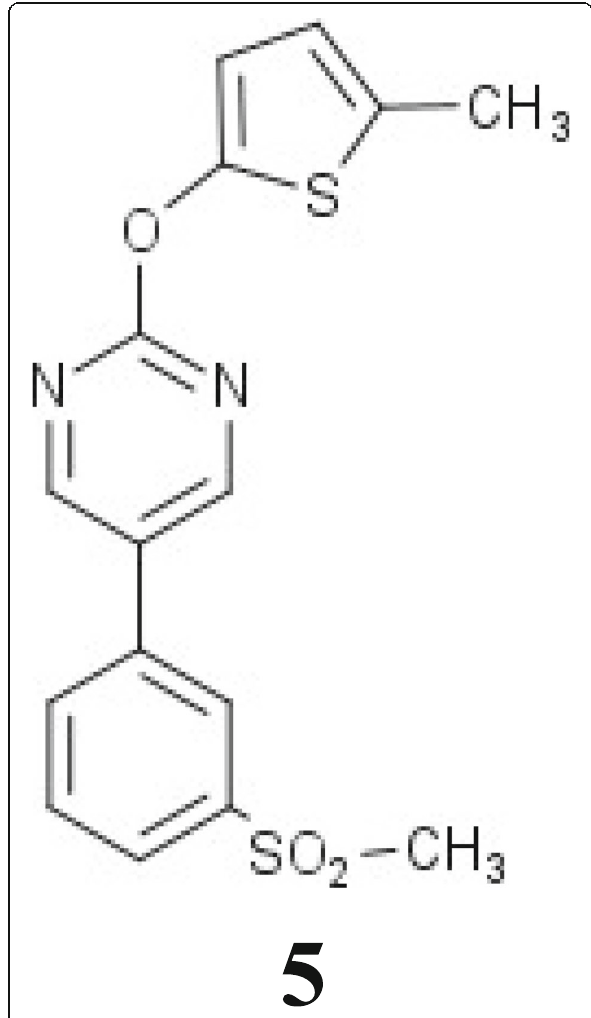
Fig. 2 Chemical structures of 2,5-disubstituted pyrimidine derivatives